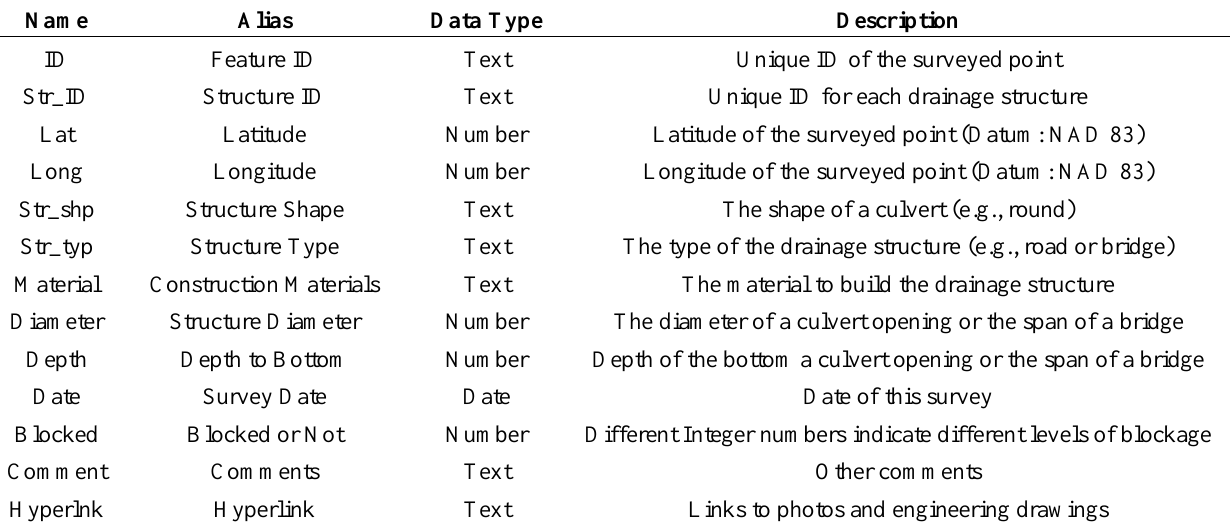
Table 4. Template for the major attributes of a drainage structure